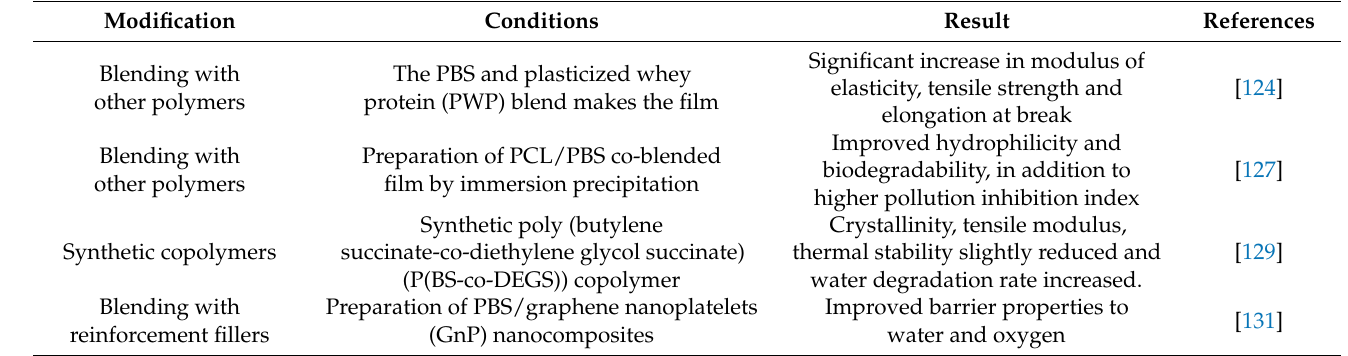
Table 7. The different modifications of PBS film materials.